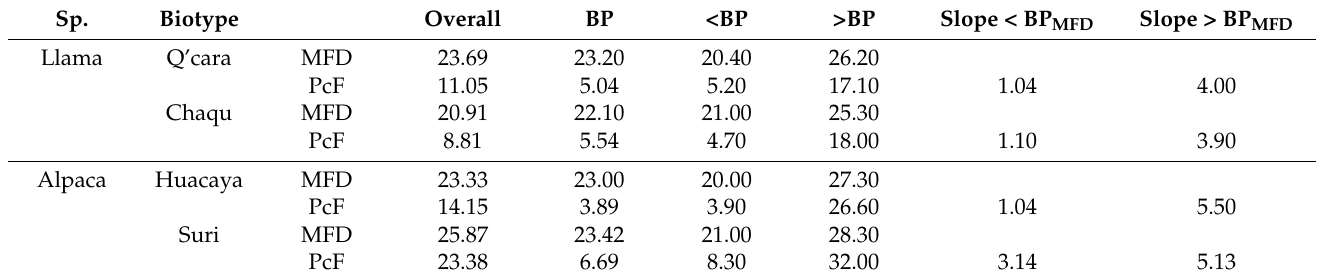
Table 1. The mean fibre diameter (MFD) and prickle factor (PcF) averages below the breaking point (<BP) and above the breaking point (>BP) in llamas and alpaca fibres.